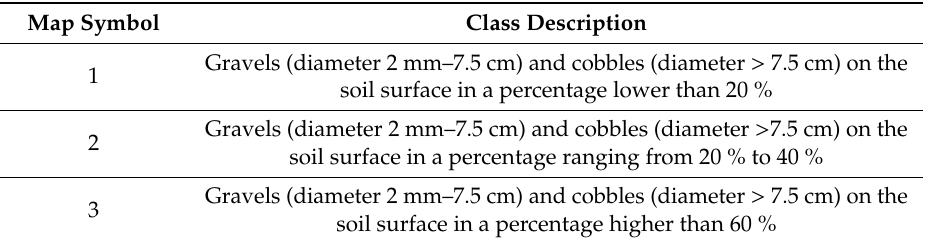
Table A3. Classes of rock fragments with the corresponding